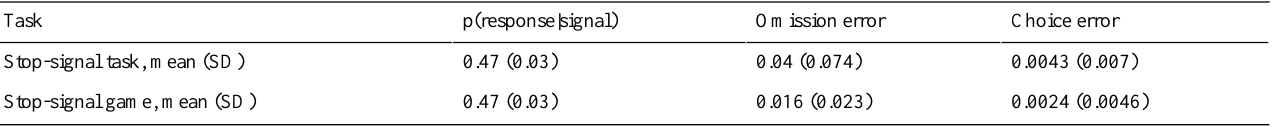
Table 2. Mean error rates and accuracy in their relative proportion to the total trial count dependent on task type for study 1. The measurements are collapsed across the order of task